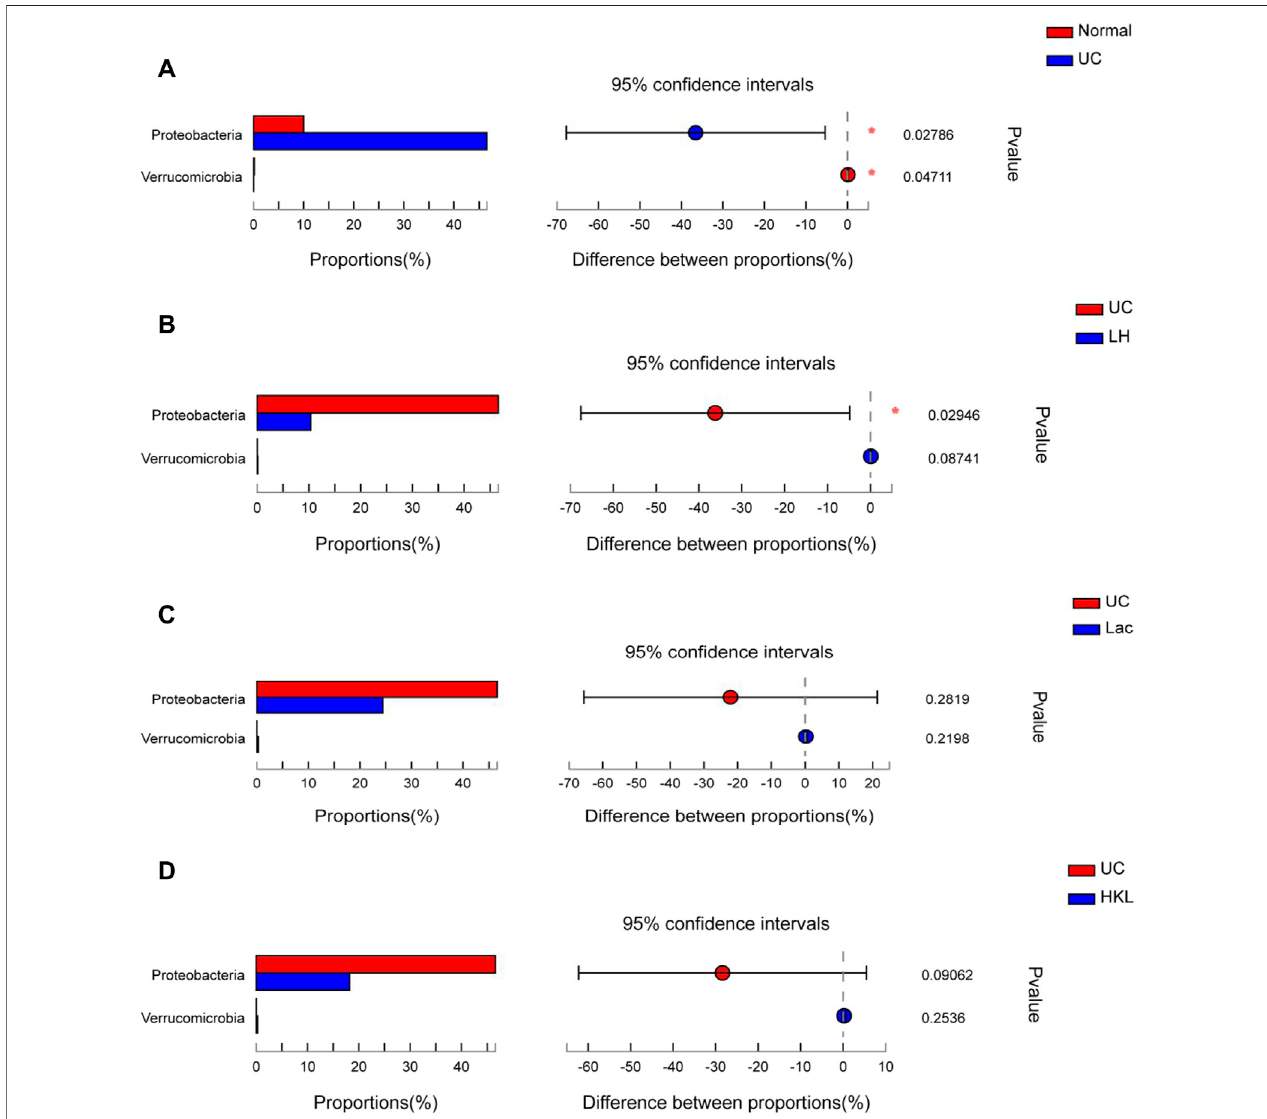
FIGURE 5 | Bar plot of gut microbiota comparison at phylum level of fi ve groups ( n = 5~6). (A) Differential phyla between the UC group and normal group. (B) Differential phyla between the UC group and LH group. (C) Proteobacteria and Verrucomicrobia comparison in the UC and Lac groups. (D) Proteobacteria and Verrucomicrobia comparison in the UC and HKL groups; *0.01 ＜ p ≤ 0.05.